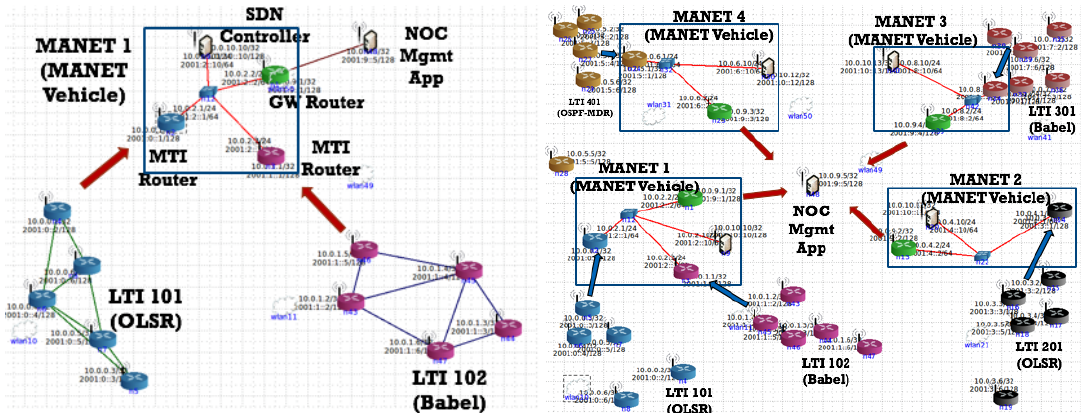
Figure 6. Scenarios of Hierarchical Network Deployment